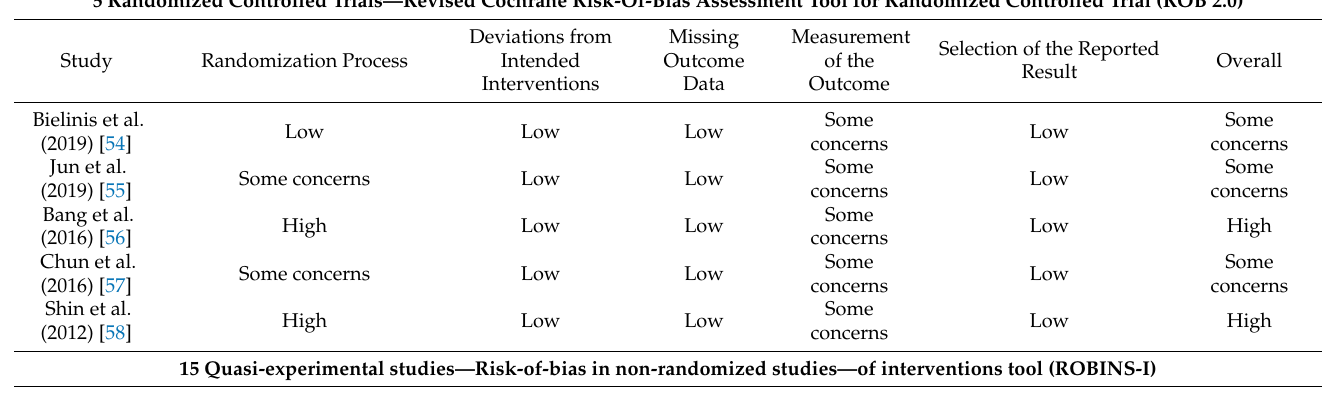
Table A2. RoB and ROBINS-I assessment of the included